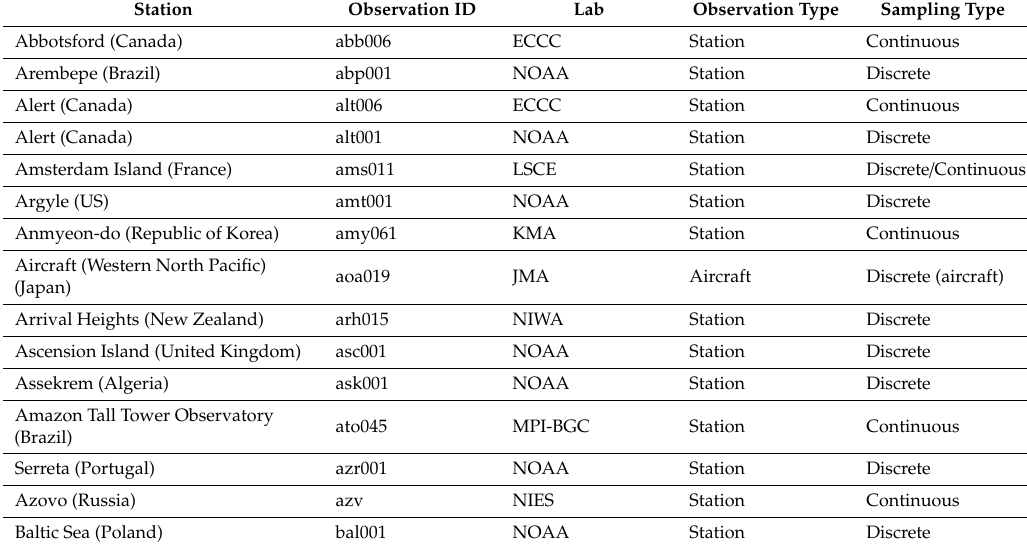
Table A1. List of observations used in this inversion. The details are Station (country), site ID, institute conducting observations, observation type, and sampling